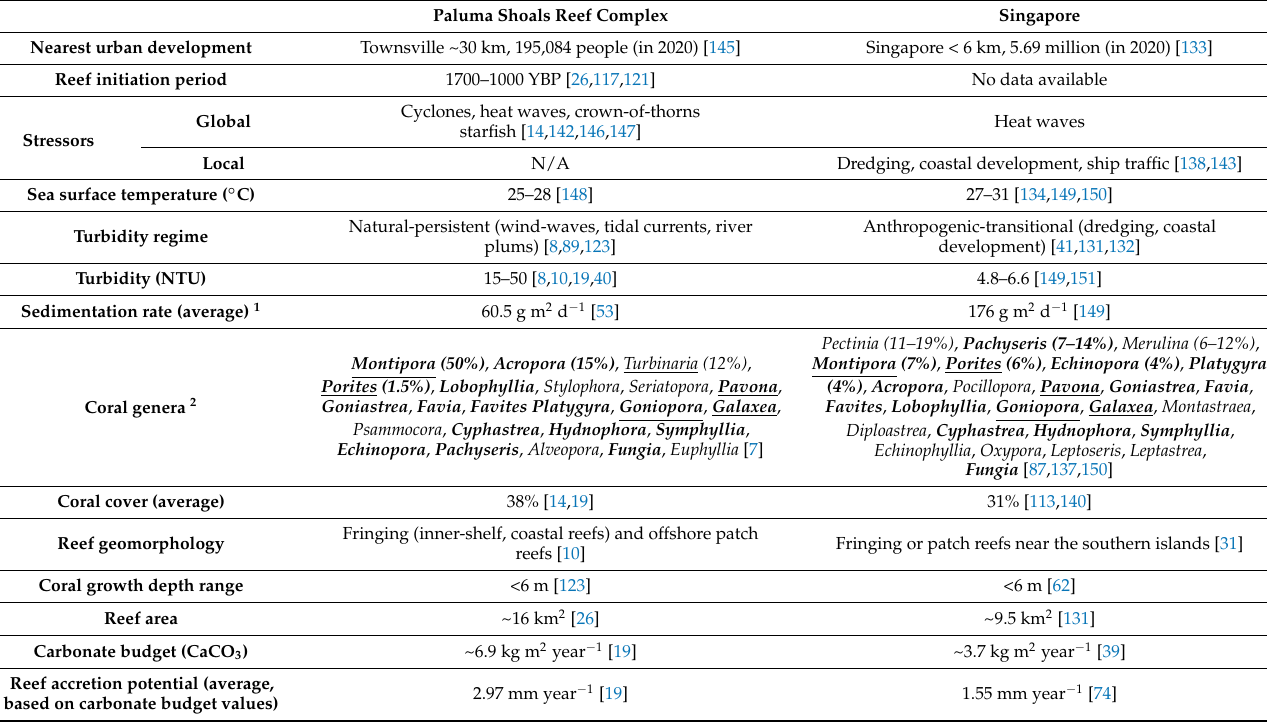
Table 1. Comparison of environmental, physical and ecological parameters at Paluma Shoals Reef Complex (PSRC) and